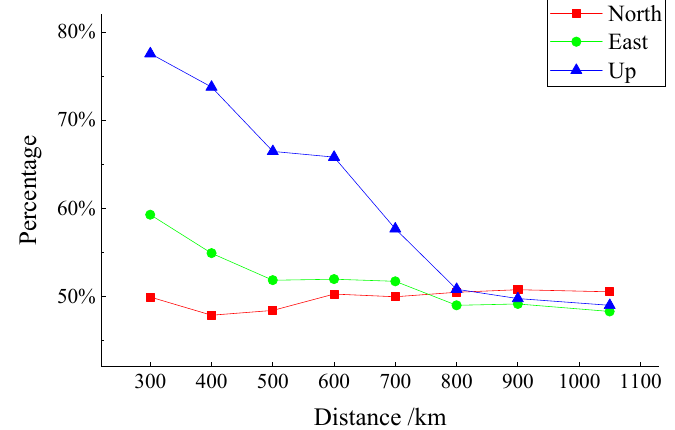
Figure 5. The relationship between region size and the percentage of first-order principal component eigenvalues in extracting CMC (Northeast Block of China).